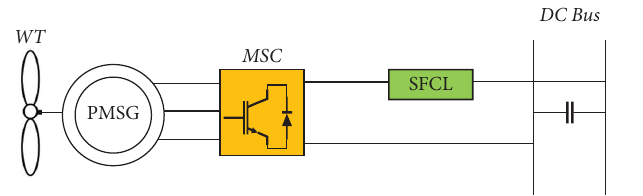
Figure 13: Connection of SFCL at the DCL.